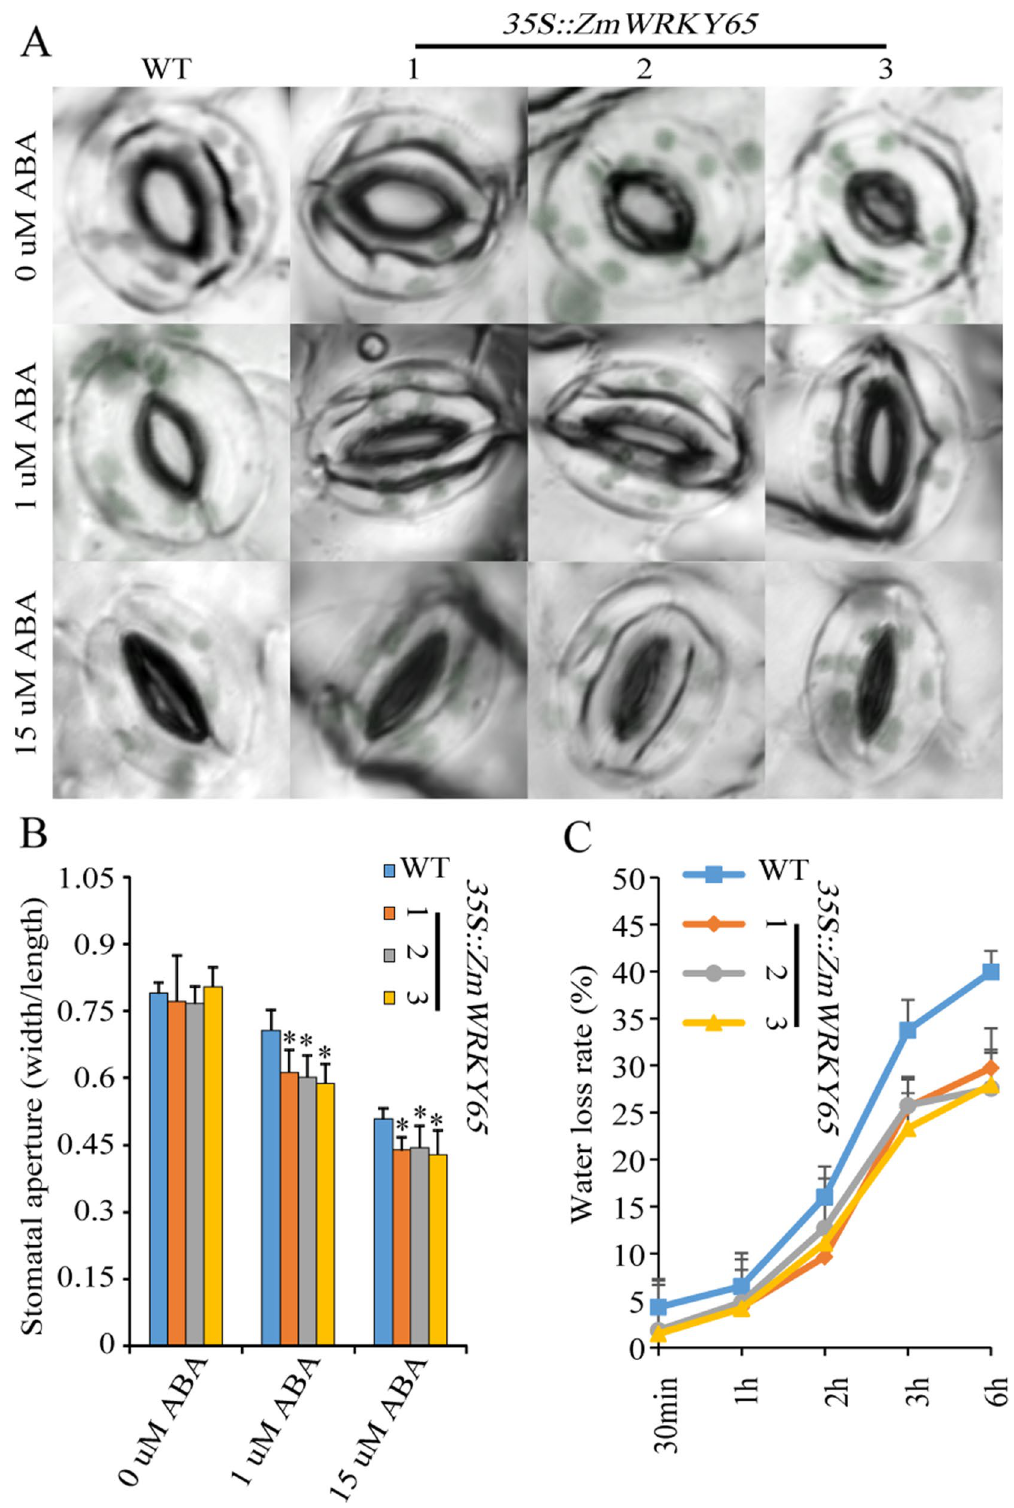
Figure 6. Effects of ABA on stomatal aperture and water loss rate. ( A ) The phenotypes of WT and ZmWRKY65 transgenic Arabidopsis plants under different concentrations of ABA treatment. ( B ) The stomatal aperture of WT and ZmWRKY65 transgenic Arabidopsis plants under different concentrations of ABA treatment. Vertical bars indicate ± SE of three replicates. * indicates significant differences in comparison with the WT lines at 0.01 < P < 0.05. ( C ) Water loss rate. Vertical bars indicate ± SE of three